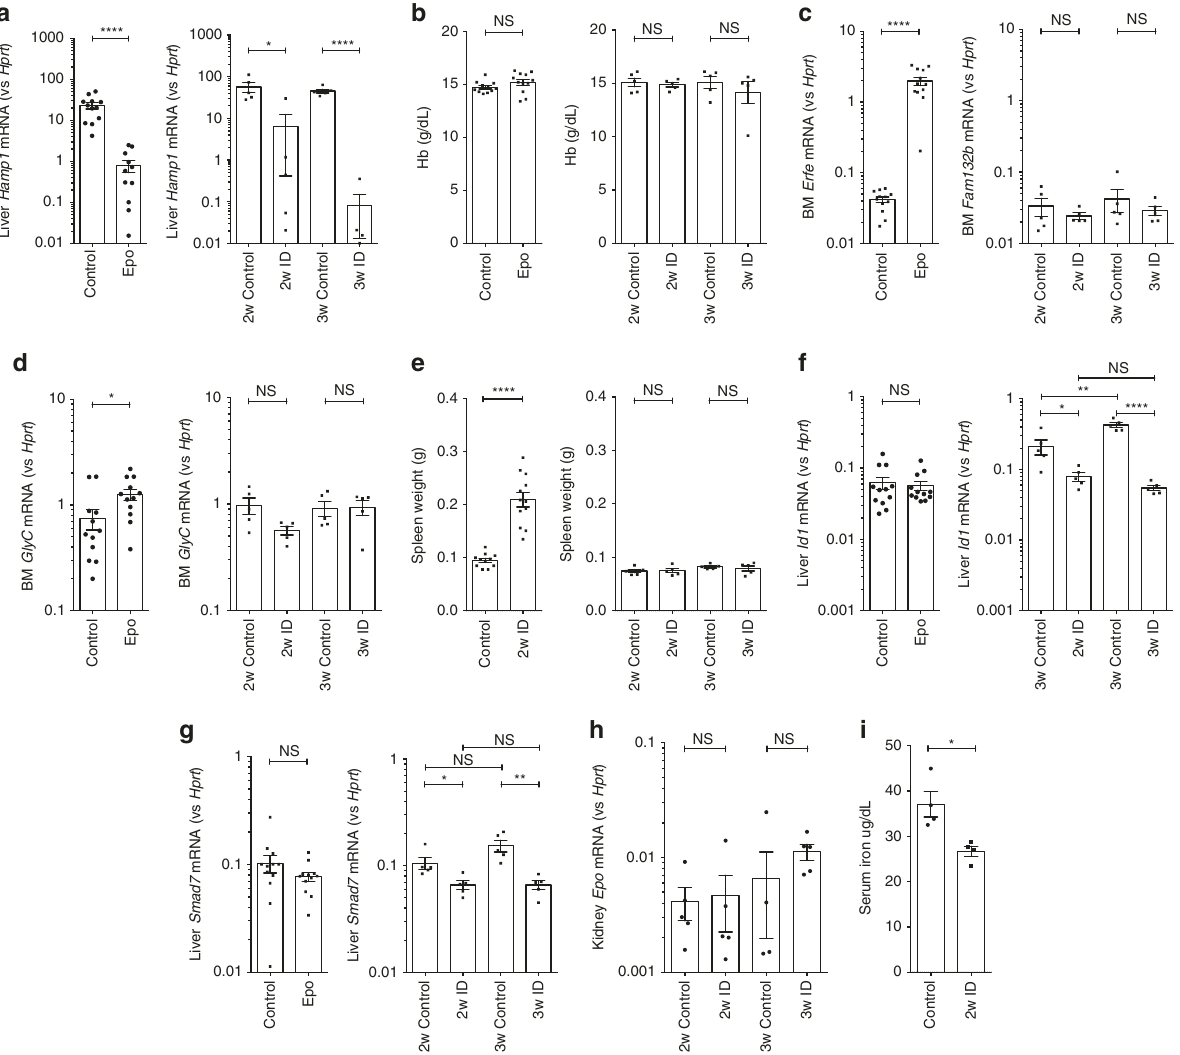
Fig. 1 Effects of erythropoietin and iron de fi ciency in vivo. Effects of (1) 3 days erythropoietin (Epo) 200IU i.p. administration and (2) 2 or 3 – weeks of iron- de fi cient (2 – 6 ppm) diet in C57Bl/6 mice, on a hepatic Hamp1 gene expression, b hemoglobin concentration, c bone marrow Fam132b gene expression, d bone marrow glycophorin C, e spleen weight, f hepatic Id1 gene expression, g hepatic Smad7 gene expression. Effects of 2 weeks iron-de fi cient diet on h renal Epo gene expression, and i serum iron. (Epo experiment n = 13 per group, 6-week-old males; iron de fi ciency (ID) experiments n = 5 per group, 4-week-old males at commencement of experimental diet). Student ’ s t -test. Data are means ± s.e.m. * P ≤ 0.05; ** P ≤ 0.01; *** P ≤ 0.001; **** P ≤ 0.0001; NS, P >